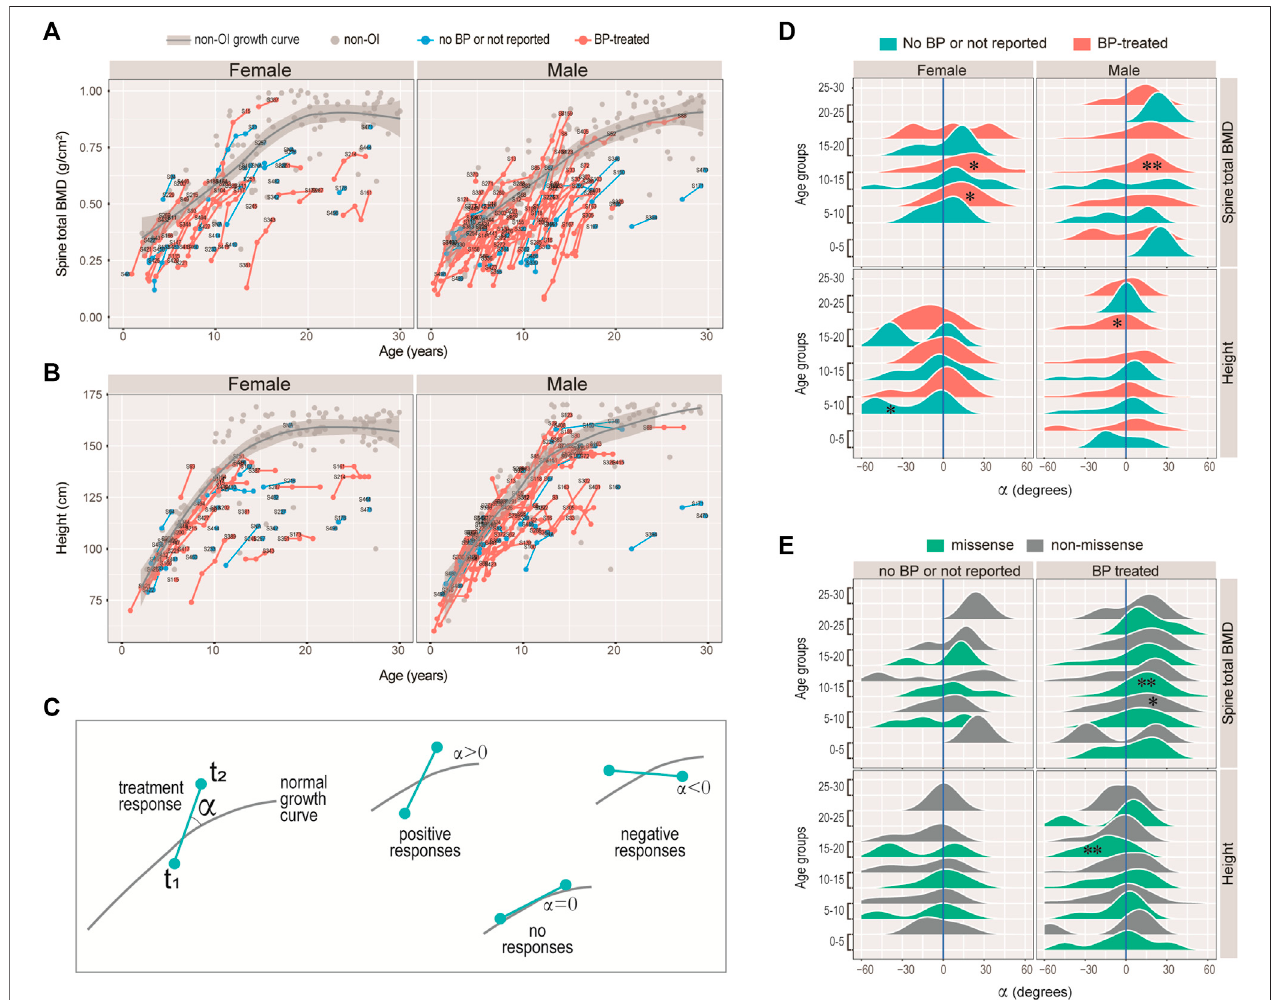
FIGURE4| Responsesofbisphosphonate(BP)treatment. (A – B) GrowthcurvesforspinalBMD (A) ,andheight (B) forthefemaleandmalepatientswith COL1A1/2 variants in our cohort. Line segments indicated measurements of the same individuals. Text labels were anonymized patient IDs. (C) Diagram illustrating the strategy measuring BP responses. The angle α was measured between the slope of the consecutive measurements and the tangential slope in the controls. A positive angle indicatesstronger growthrateascompared withthecontrols,and anegative oneindicatesotherwise. (D – E) RidgeplotsshowingtheBPresponsesofspinalBMD and height with respect to sex, BP-history and age-groups (D) , or to variant type, BP-history and age-groups (E) . *: Wilcoxon test p < 0.05; **: p < 0.01; unmarked box: no signi fi cant difference. ( Figure 4B ) readings of the same individuals were shown, with grey dots indicating the non-OI readings of BMD and height, and their fi tted curves (Methods) with standard error band.